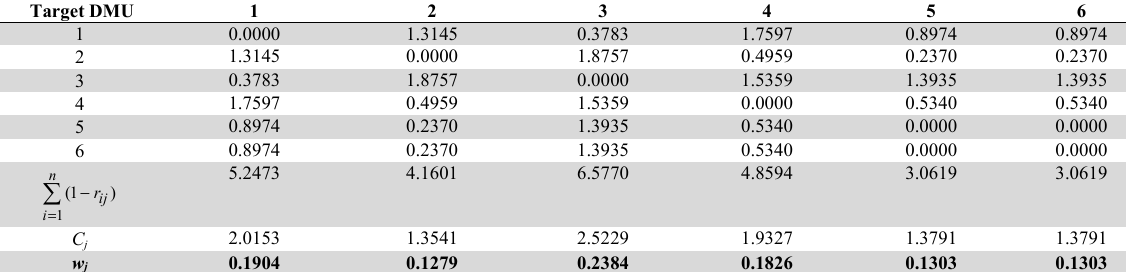
Criteria weights for six nursing homes using the CRITIC method Target DMU